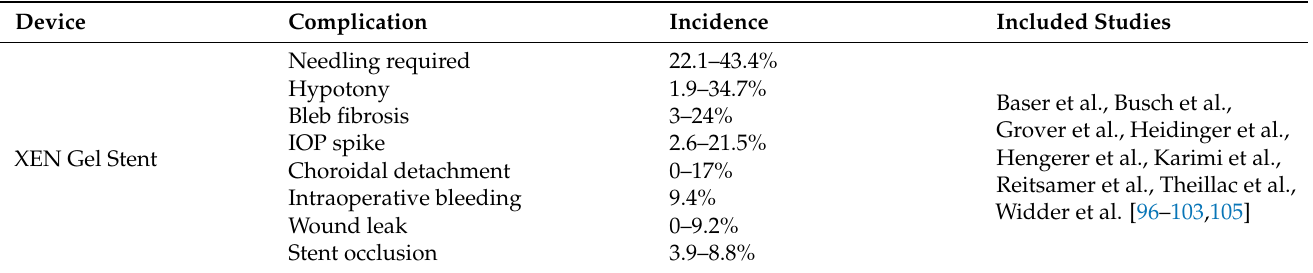
Table A3. Complication Rates of Devices Shunting Aqueous Outflow into the Subconjunctival